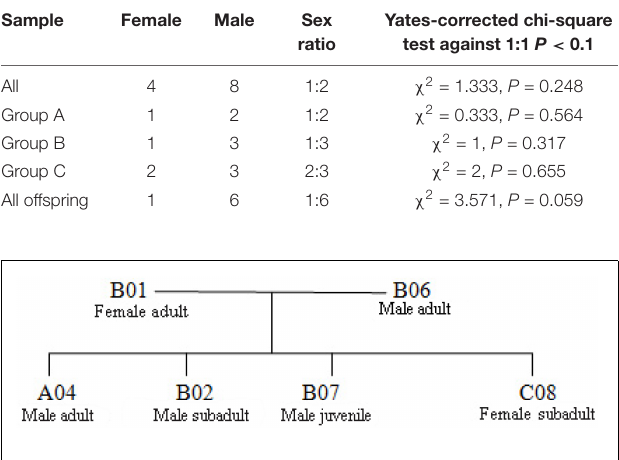
FIGURE 5 | Genetic maps of 3 Hainan gibbon groups. TABLE 5 | Parent–offspring pair inferred using the software COLONY.